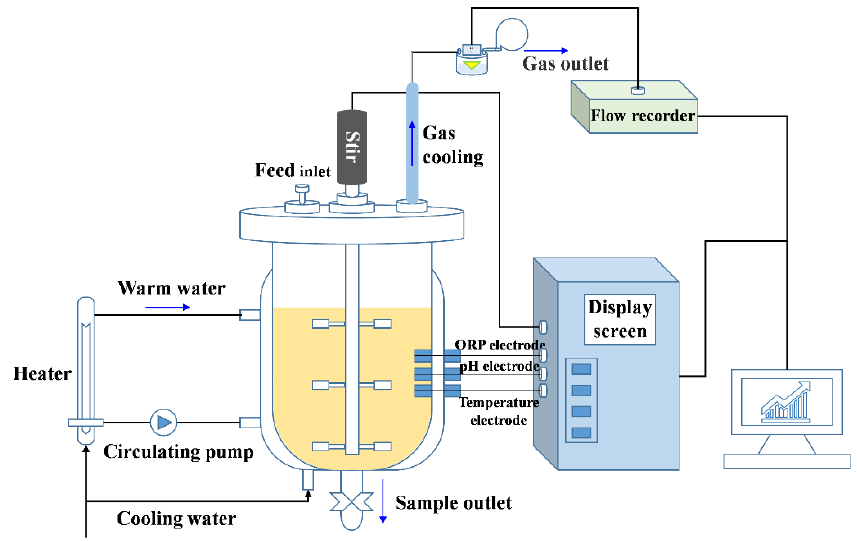
Figure 1. The fermentation system used for anaerobic fermentation experiments.